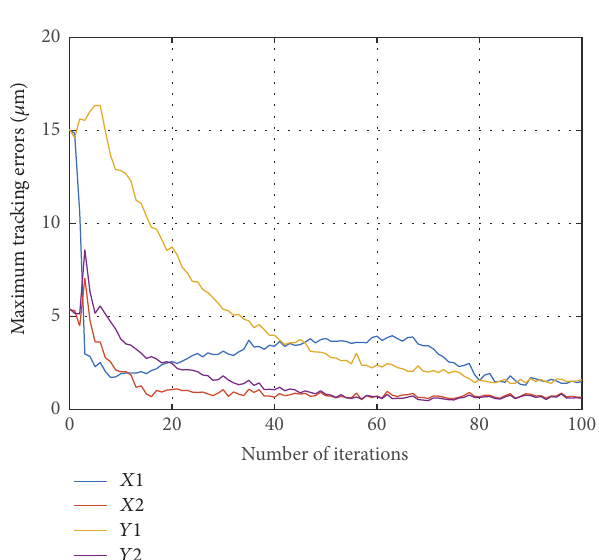
Figure 12: The maximum tracking errors versus number of itera- tions.